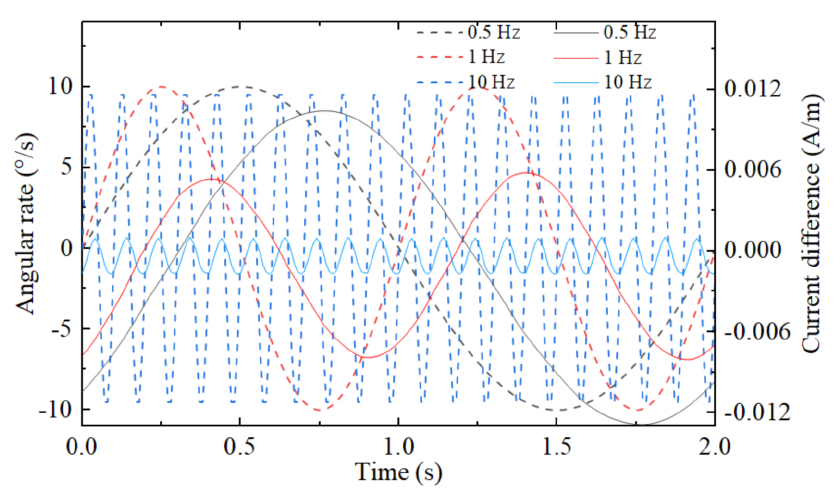
Figure 4. Angular rates and output current differences for the case of fre = 0.5 Hz, fre = 1 Hz and fre = 10 Hz in the time domain. The dotted lines represent the relationship between external angular rate and time, and the solid lines represent the relationship between current difference and time.